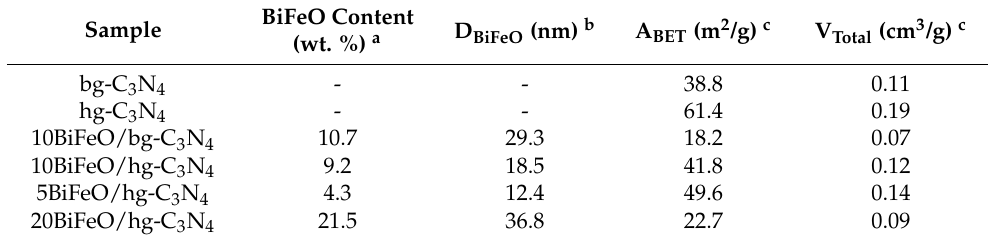
Table 1. Structural and textural properties of the catalysts.